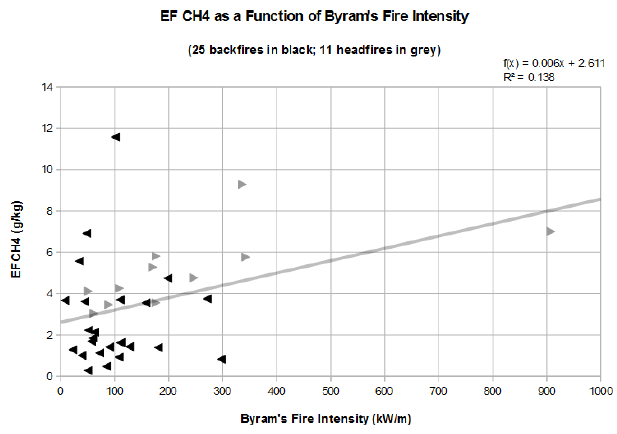
Figure 3. Methane EF as a function of Byram’s fire intensity for all fires. Arrows indicate fire type (2014–2016, Mali).